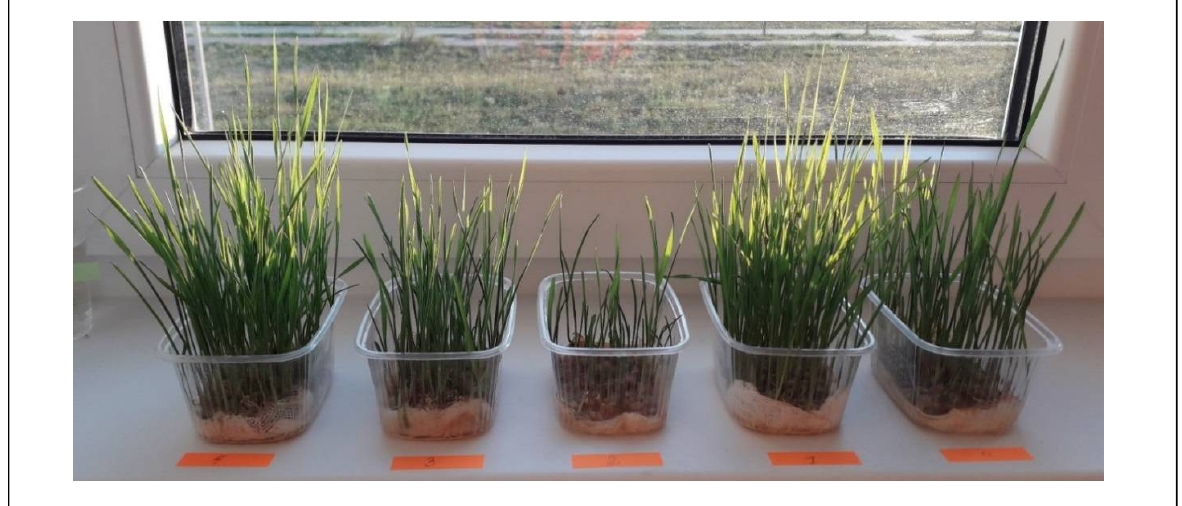
Figure 12: Tríticum durum in ordinary and “saturated” water (August 27,